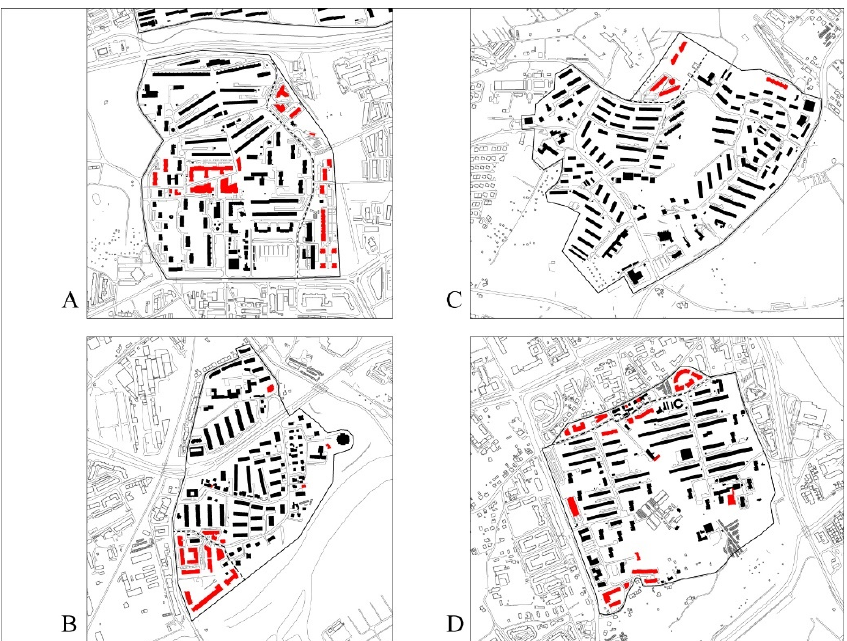
Figure 5. Densification with single buildings or clusters of new buildings on the edges of the housing estates, shifting their boundaries (the extended area is marked with a dotted line)—selected examples of housing estates: ( A )—Krowodrza Górka (3), ( B )—D ą bie (9), ( C )—Wzgórza Krzesławickie (20), ( D )—Podwawelskie (21). Color legend: black—developments from before 1995; red—densification—developments from after 1995.